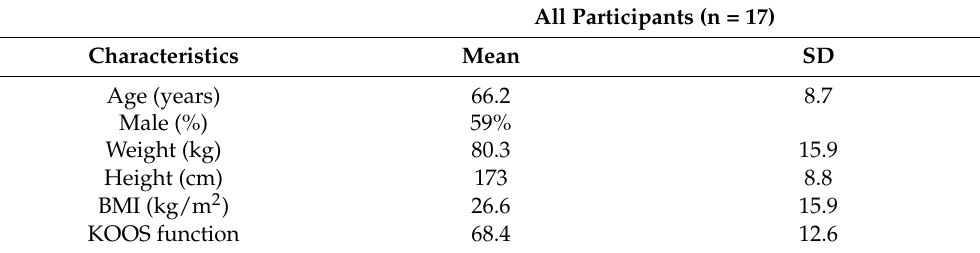
Table 2. Characteristics of participants.